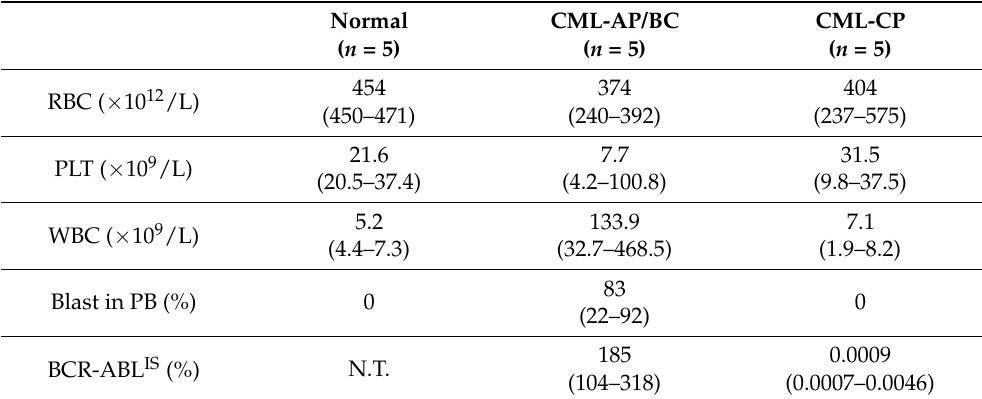
Table 1. Summary of healthy volunteer and CML